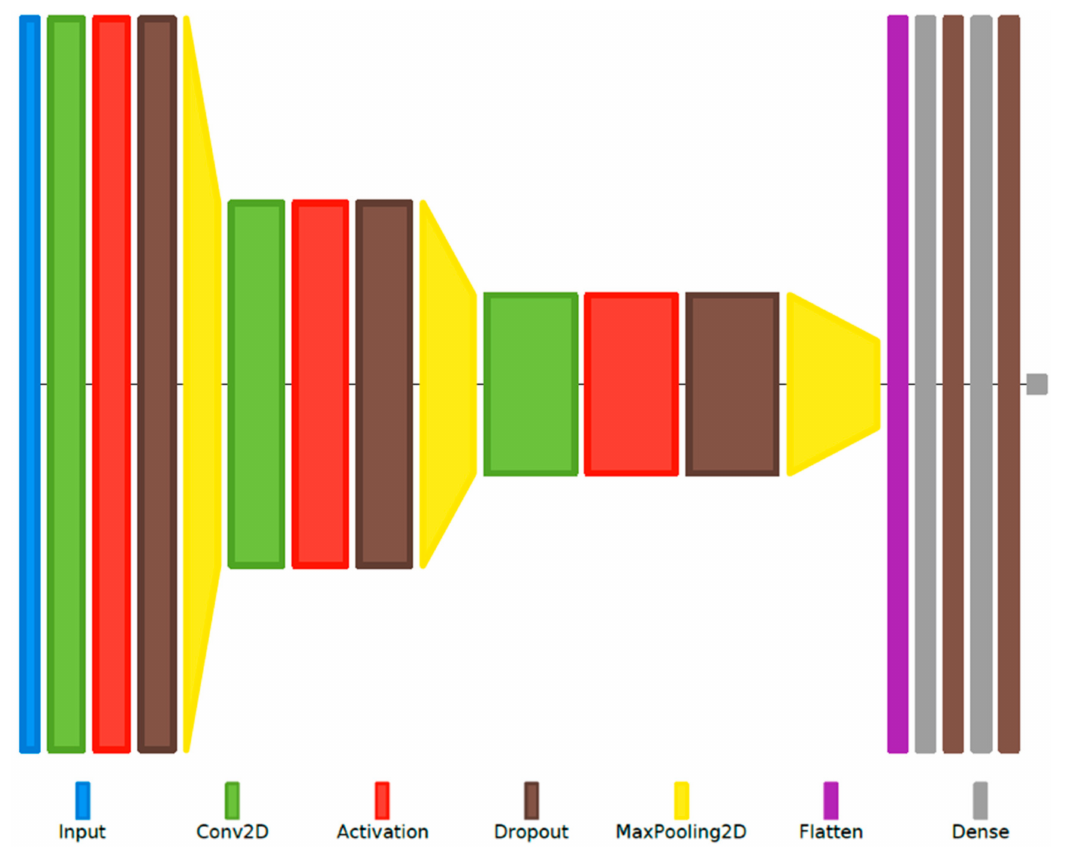
Figure 8. Layer diagram representation of the CNN-based DSD system. In this configuration example, the three convolutional (Conv) layers use 16, 32, and 64 filters, respectively, with kernel sizes of 3 × 3. The size of the max-pooling layers used after the Conv layers is 2 × 2. The third Conv layer’s output is flattened into a one-dimensional vector and fed through two fully connected hidden layers with 32 nodes each, used together with the output layer with the “softmax” activation function for utterance-level